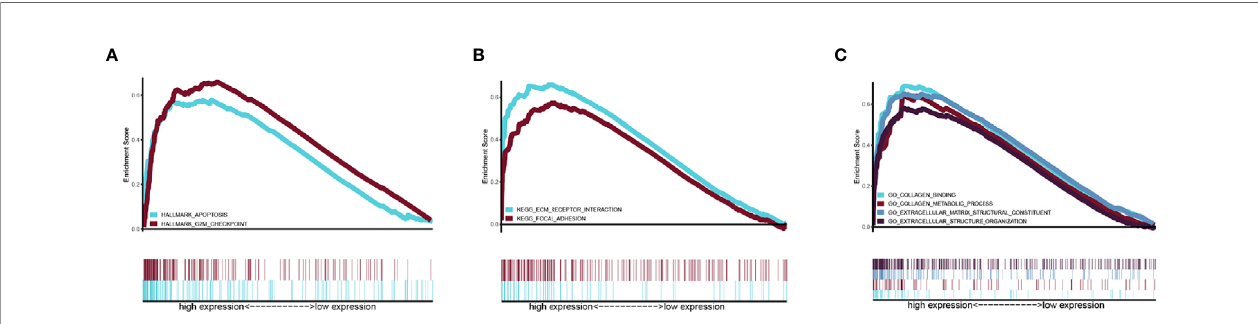
FIGURE 6 | Related pathway were analyzed by GSEA. (A) Hallmark analysis of our signature (B) KEGG analysis of our signature. (C) GO analysis of our gene